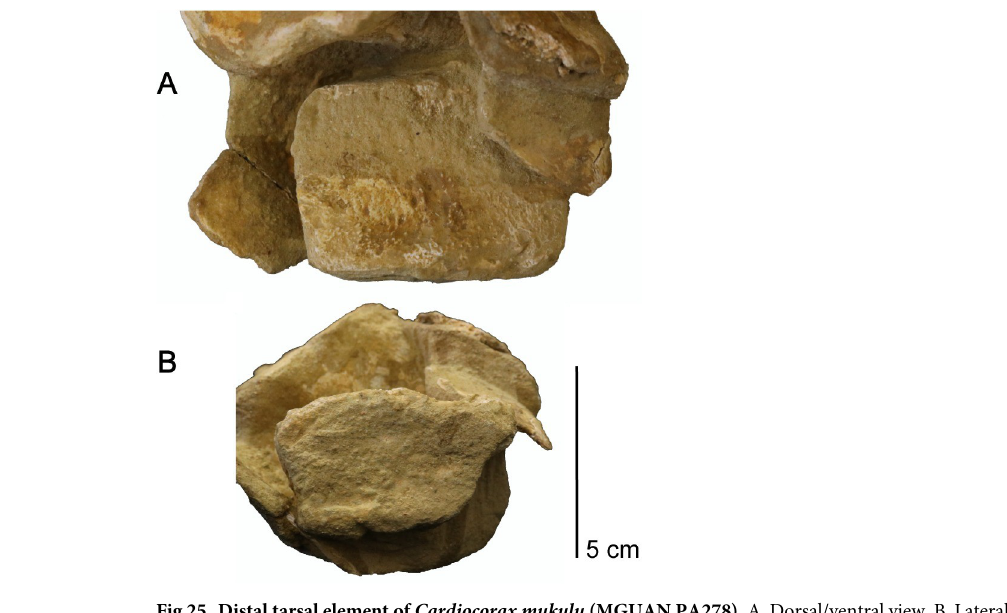
Fig 25. Distal tarsal element of Cardiocorax mukulu (MGUAN PA278). A. Dorsal/ventral view. B. Lateral view. The anterior cervical vertebra associated with MGUAN PA103 (Fig 2 in Arau´jo et al., 2015) [26] is morphologically indistinguishable from the anterior cervical vertebrae of MGUAN PA278. MGUAN PA278 shares with the holotype of Cardiocorax mukulu (MGUAN PA103) a single apomorphy where the morphology of the neural spines allows for near contact between